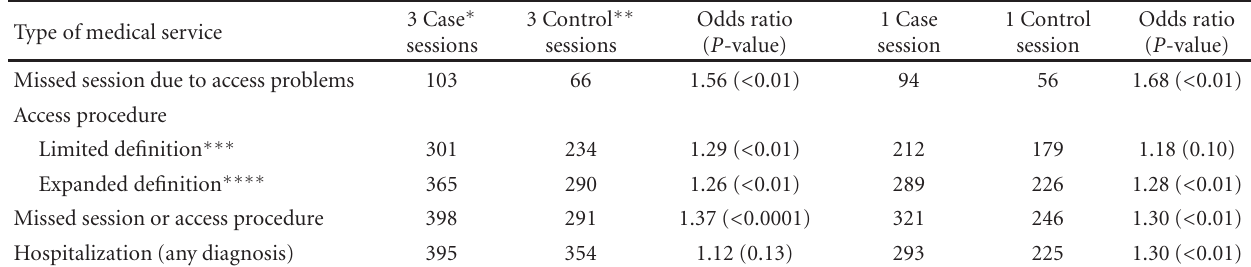
Table 2: Case-crossover analysis of medical services associated with catheter dysfunction.